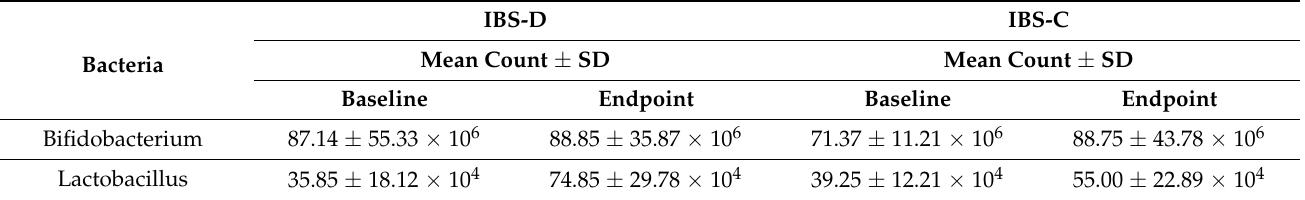
Table 2. Microbiota changes from baseline to endpoint.